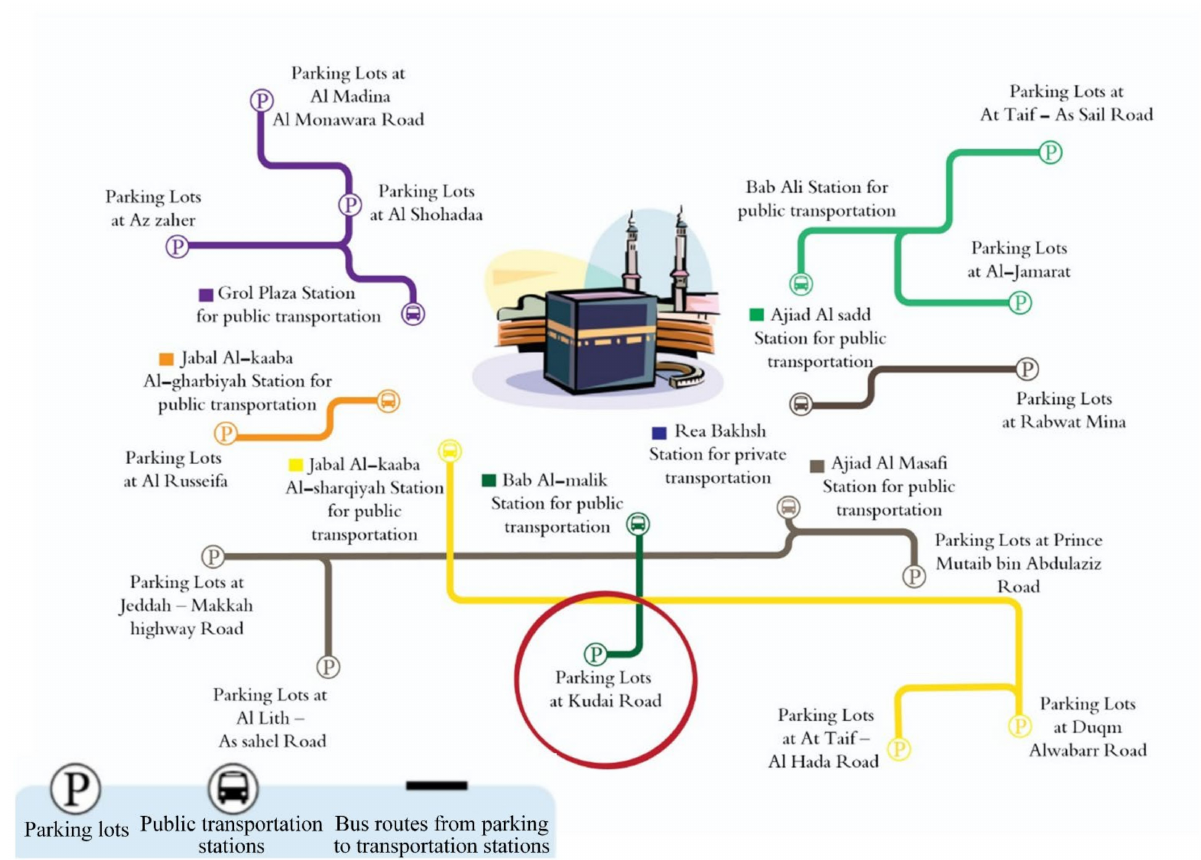
Figure 6. Parking lots and transportation stations near the holy mosque at Makkah